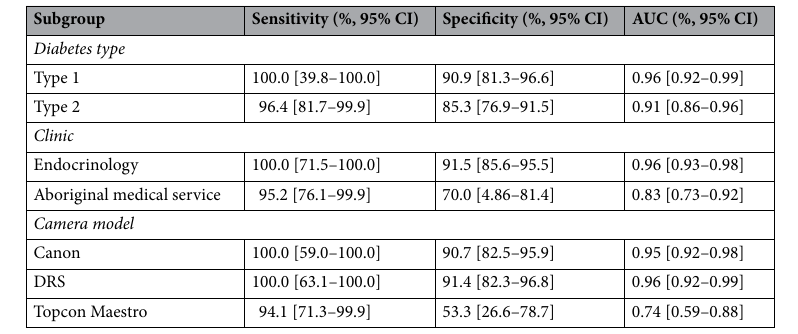
Table 4. Sub-group analysis (n =